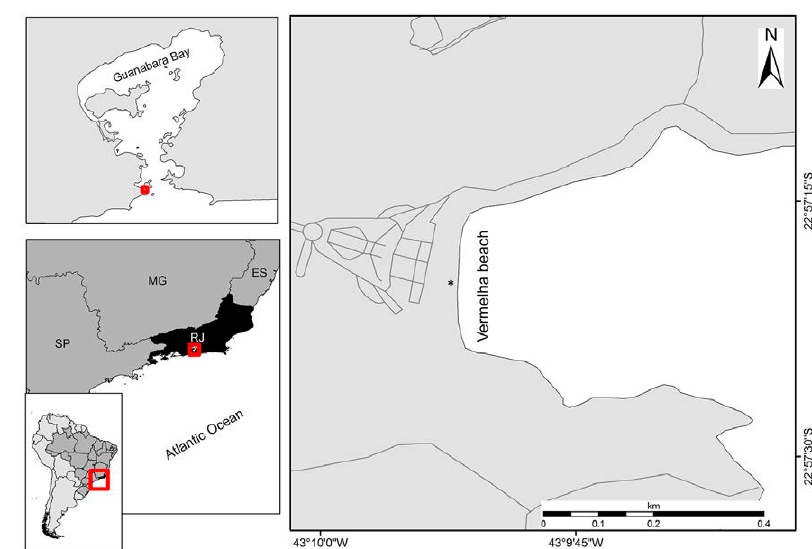
Fig. 1. – Location of Vermelha Beach in Guanabara Bay, Rio de Janeiro, Brazil, showing the position of the sampling station